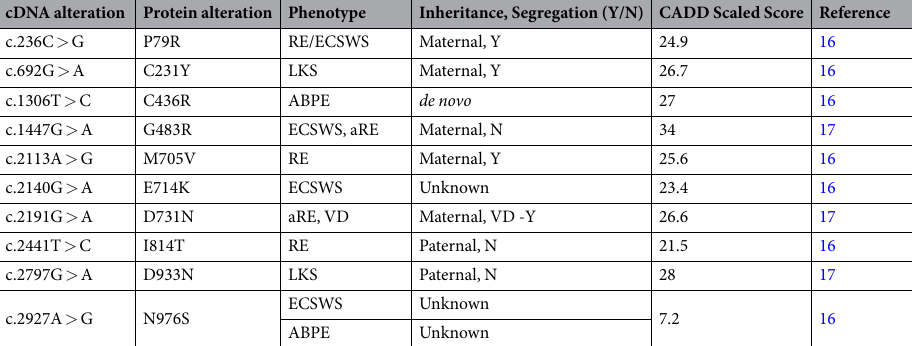
Table 1. Summary of clinical and genetic information for studied GRIN2A mutations. cDNA annotation based on the canonical transcript ENST00000396573. Phenotype abbreviations as follows: ABPE – atypical benign partial epilepsy, aRE – atypical Rolandic epilepsy, CSWS – epileptic encephalopathy with continuous spike and wave during slow wave sleep, LKS – Landau-Kleffner Syndrome, RE – Rolandic epilepsy, VD – verbal dyspraxia. Y-yes, N-no for segregation of variants with phenotype. CADD score stands for “combined annotation dependent depletion”, a tool for scoring the deleteriousness of single nucleotide variants and were generated using v1.3 on 19 May 2016 from http://cadd.gs.washington.edu/. A score > 20 indicates the top 1% most deleterious substitutions 20